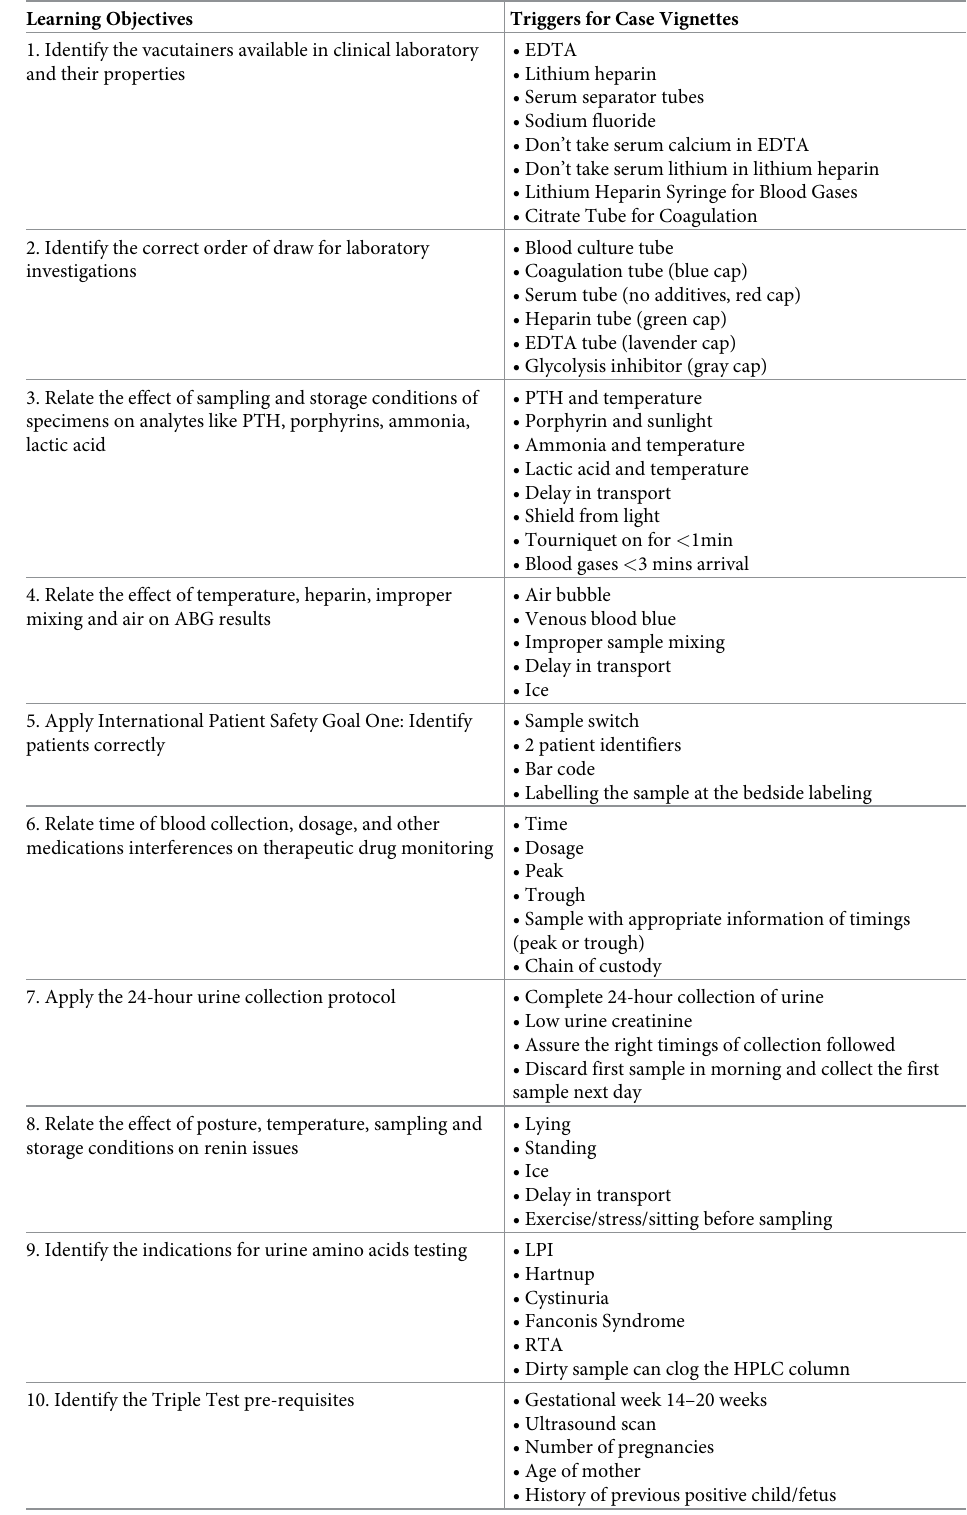
Table 1. Agreed-upon learning objectives and triggers to be included in the final